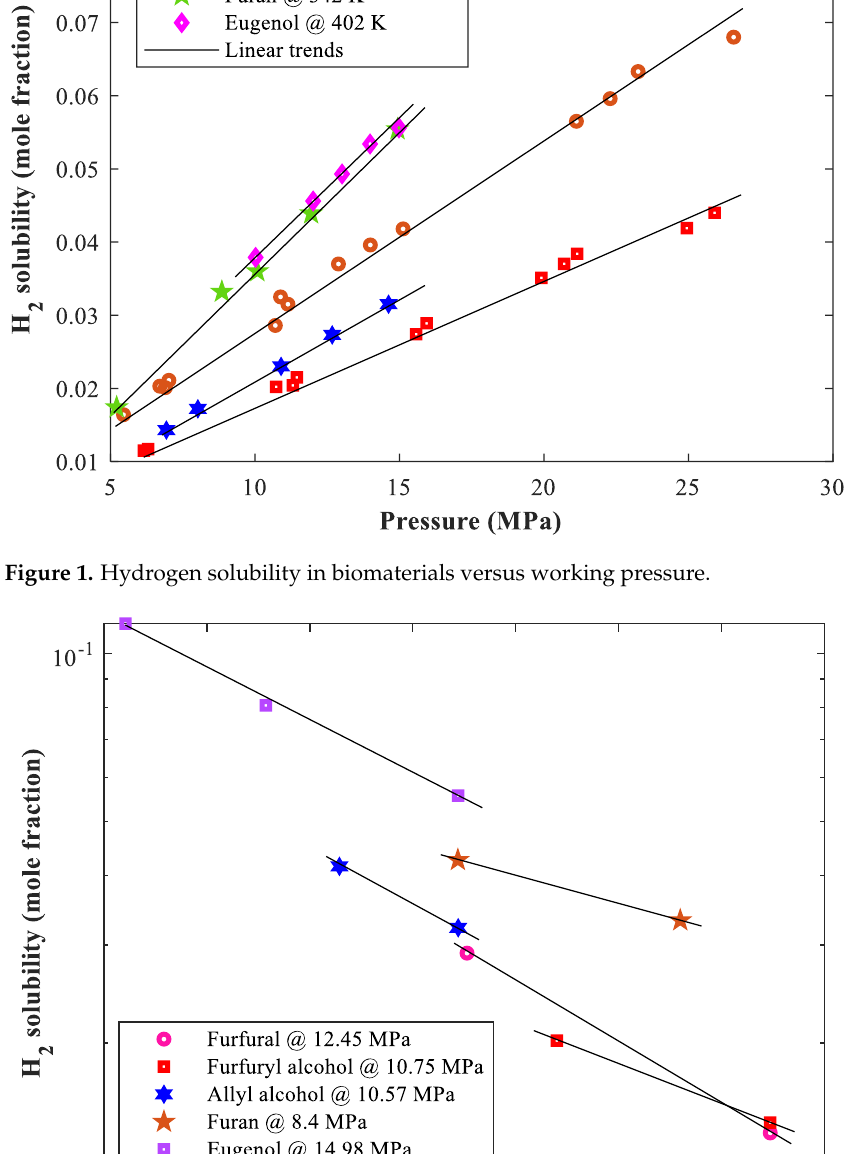
Figure 2. Variation of H 2 solubility by temperature (semi-logarithm scale).